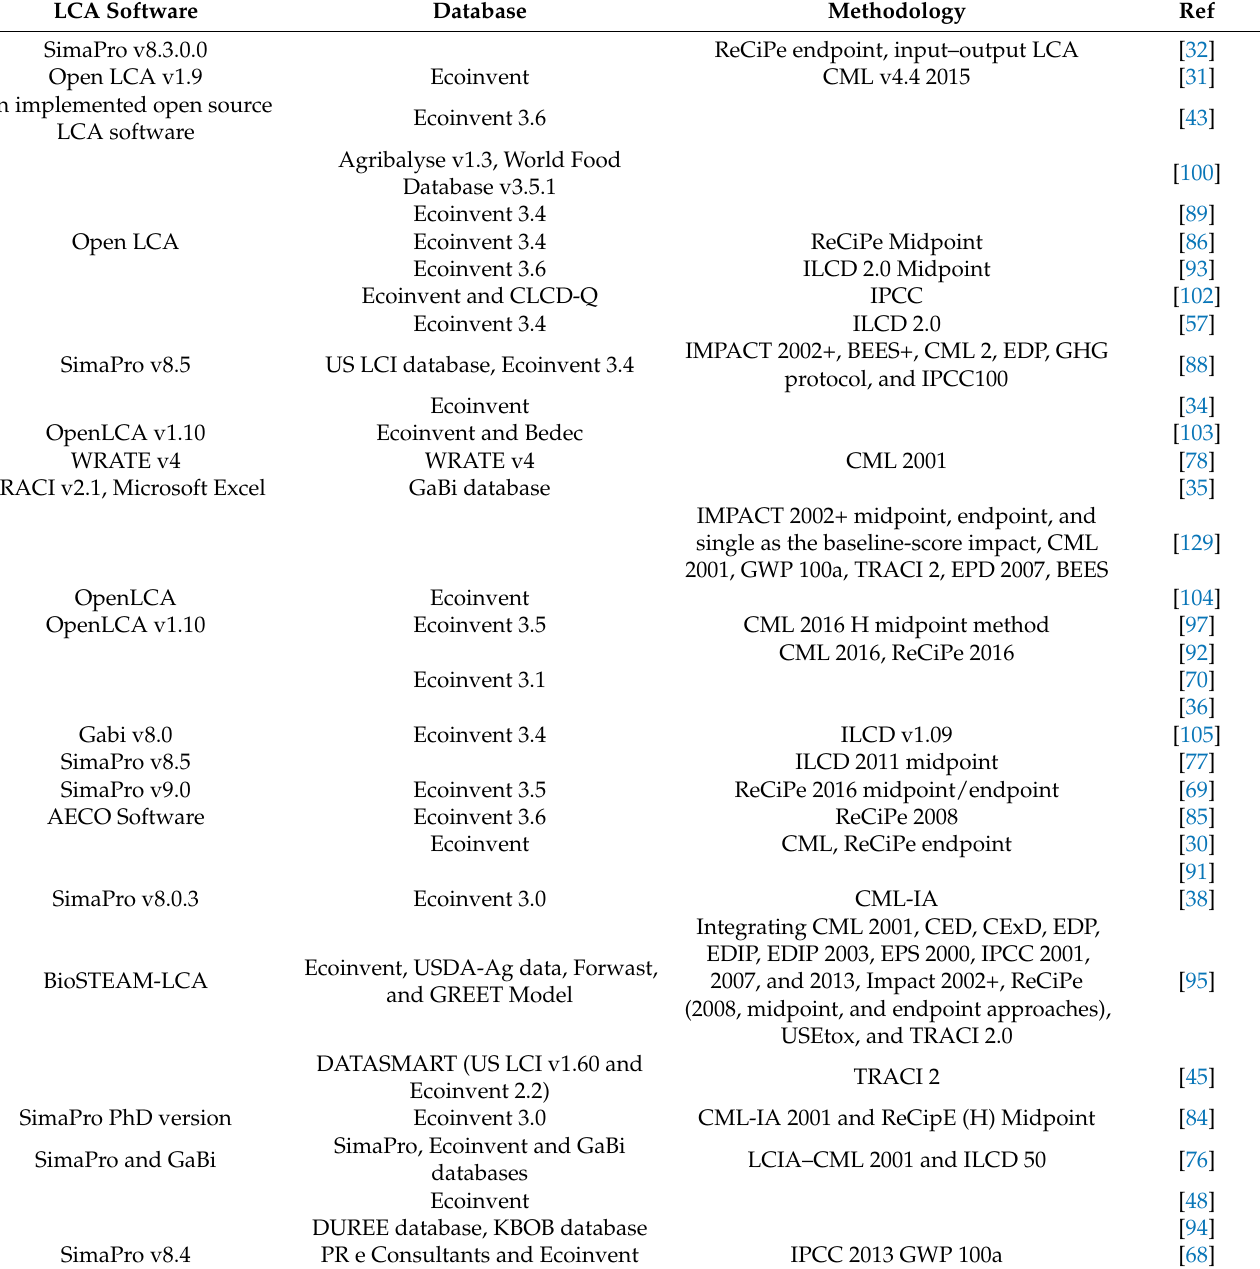
Table 9. LCA’s software, databases, and methodologies in the selected